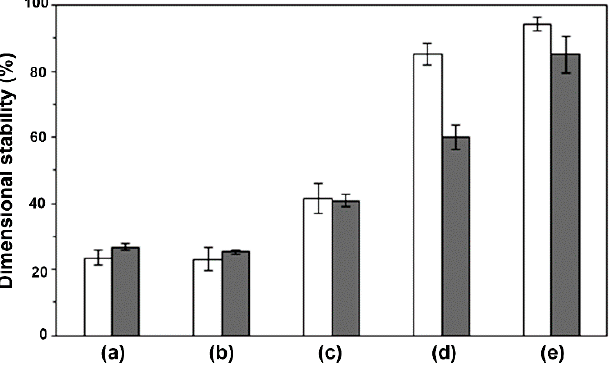
Figure 6. Dimensional stability to heat of ( (cid:3) ) non-chain-extended and ( (cid:4) ) chain-extended scPLA films with PLLA/PDLA ratios of (a) 100/0, (b) 90/10, (c) 80/20, (d) 70/30 and (e) 60/40 ( w / w ).